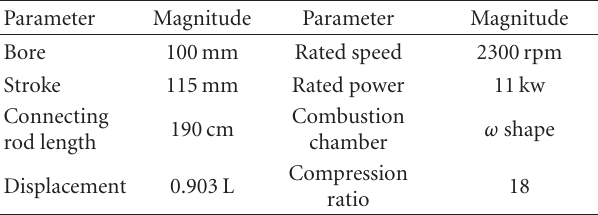
Table 3: Specification of DI diesel engine